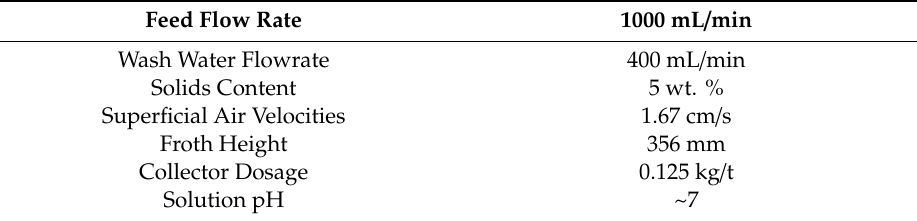
Table 3. Operational parameters for laboratory column flotation tests.